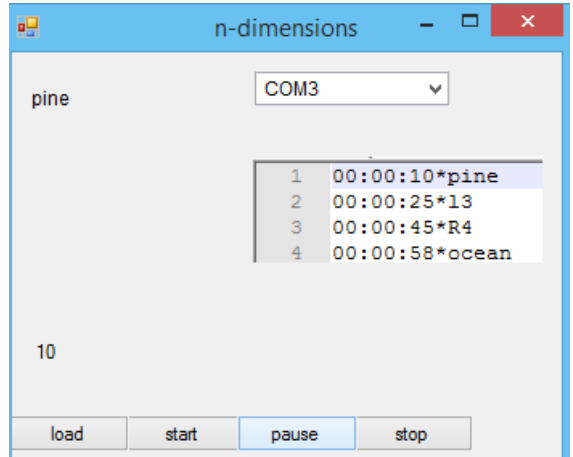
Figure 5. The olfactory control application.